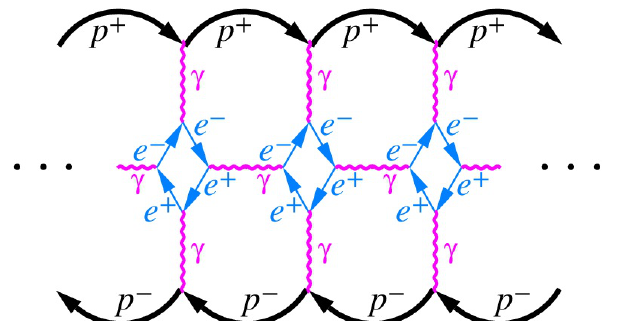
Figure 6. Feynman’s diagram of boson ( p + p − ) consisting of proton p + and antiproton p − coupled by exchanging γ -quanta through electron-positron interactions. The latter provides the superflu- idity effect that is like the Cooper pairs due to a correlated state of electrons with opposite spins and